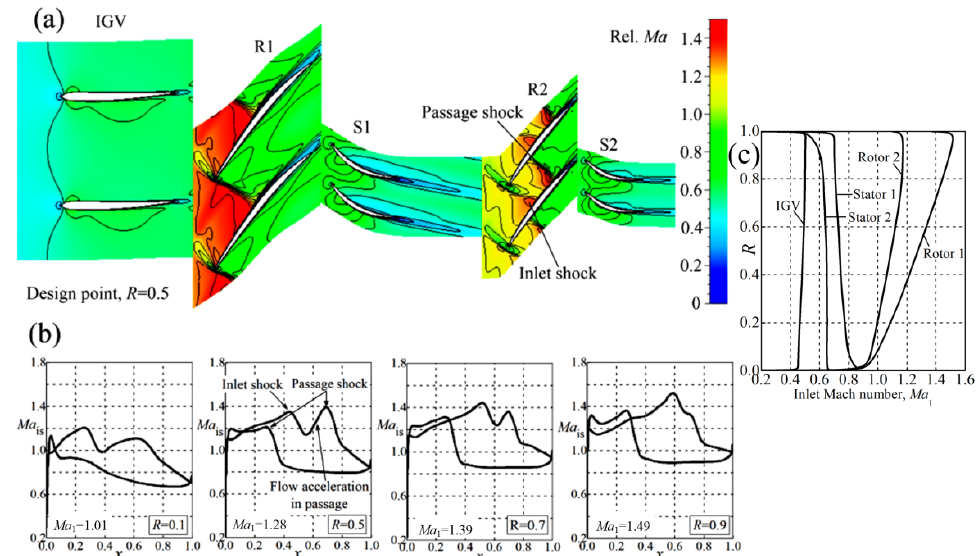
Figure 4. The flow field relative Mach number at mid-span ( a ), Rotor 2 surface isentropic Mach number at R = 0.1, 0.5, 0.7 and 0.9 ( b ), and blade inlet Mach number radial distribution ( c ).